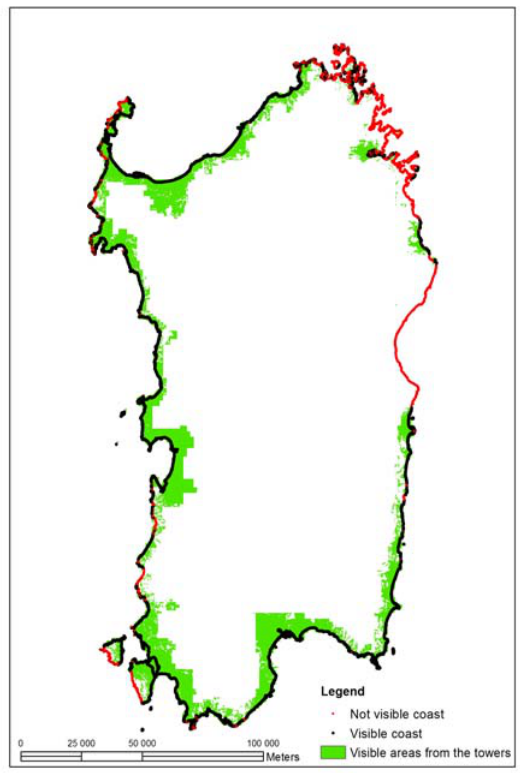
Figure 13: Visibility study of the coast